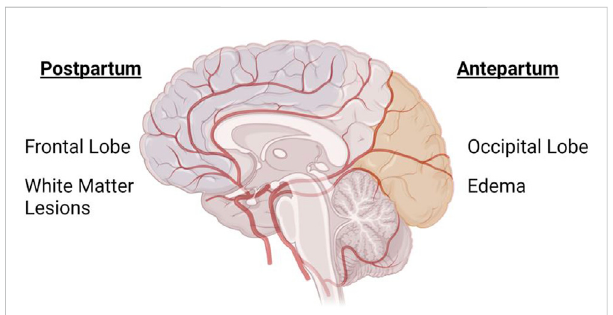
FIGURE 1 Anterior and Posterior cerebrum are differentially affected in antepartum and postpartum periods inpreeclampsia. Image shows an overlay of the cerebral vasculature over the brain, highlighting the different areas of the brain that are primarily affected during (pre) eclampsia-complicated pregnancy. During pregnancy, the posterior cerebrum (occipital and parietal lobes) is most commonly affected, while white matter lesions are more prevalent in the anterior cerebrum/frontal lobe of women with a history of (pre)eclampsia. Created with